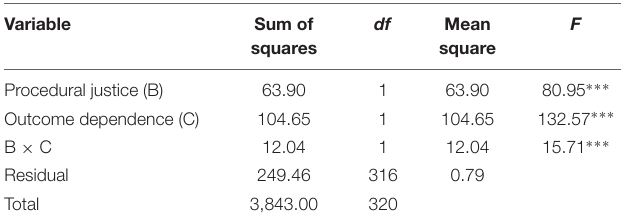
TABLE 4 | ANOVA testing the effects of procedural justice, outcome dependence, and their interaction on public cooperation intention. Variable Sum of